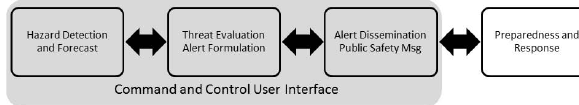
Fig. 2. End-to-End Tsunami Warning and Mitigation System (UN- ESCO, 2011a) with